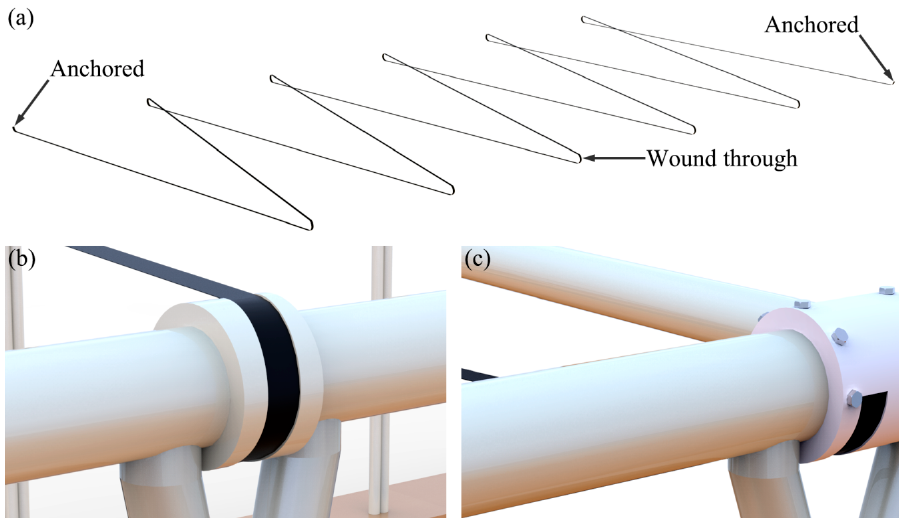
Figure 32. ( a ) CFRP continuous band used; ( b ) intermediate node; and ( c ) end node.